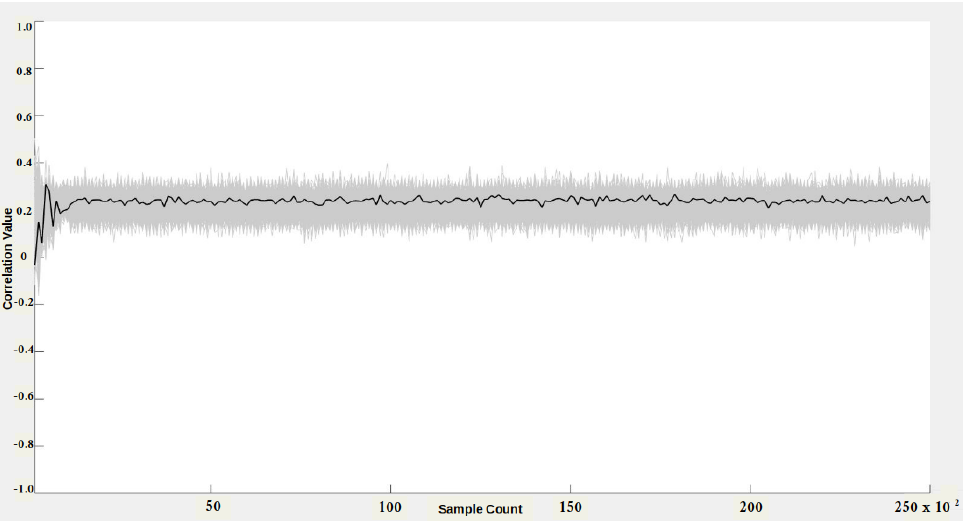
Figure 10. CPA attack on Arithmetic